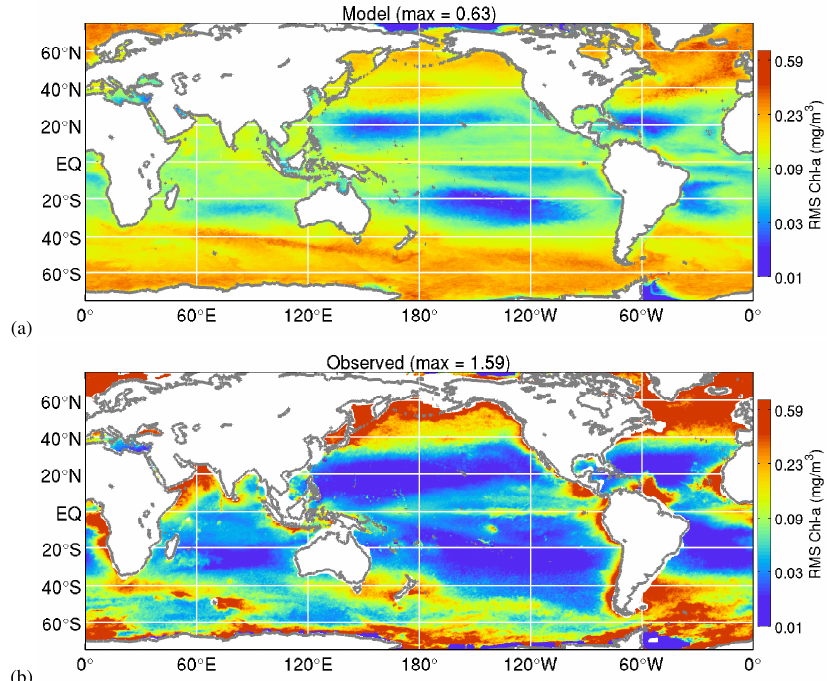
Fig. 15. Comparison of the RMS of the surface chlorophyll a from the model (top) and from SeaWiFS (bot- tom).